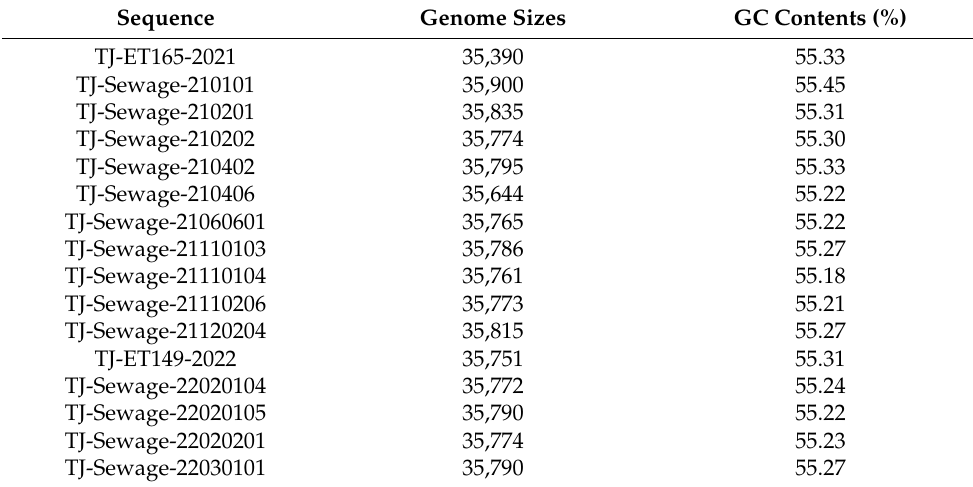
Table 1. Genome sizes and GC contents of 16 Tianjin